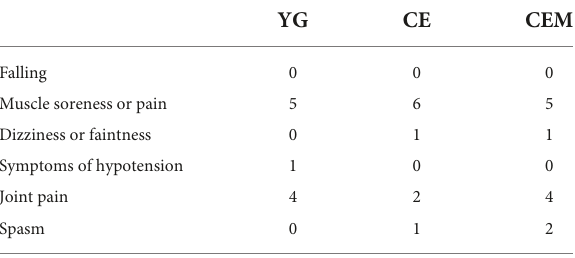
TABLE 3 Adverse events among the yang-ge dancing, conventional exercise, and conventional exercise plus music groups. YG CE CEM Falling 0 0 0 Muscle soreness or pain 5 6 5 Dizziness or faintness 0 1 1